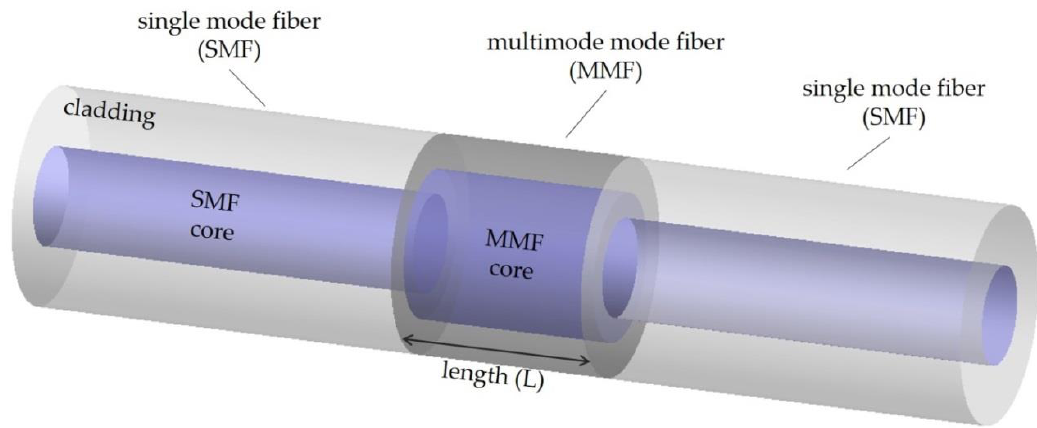
Figure 3. Schematic configuration of the single-mode-multimode-single-mode fiber structure.